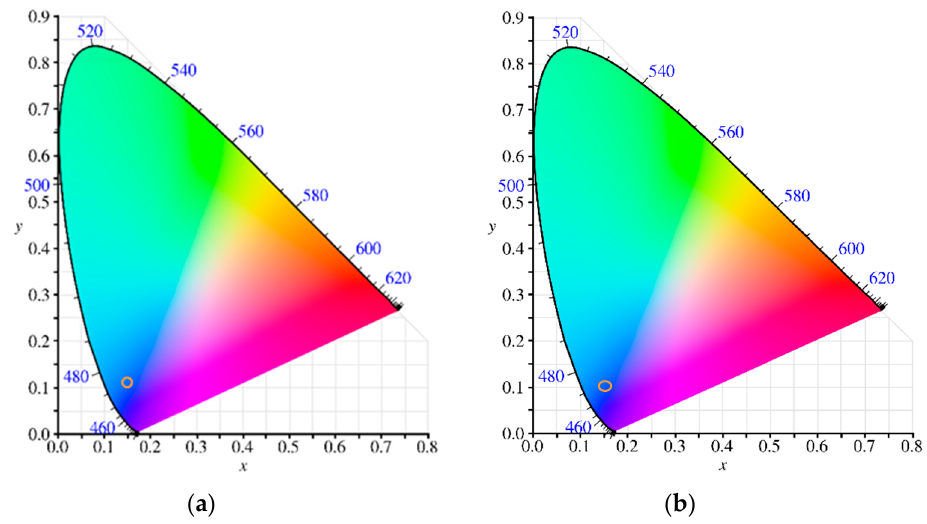
Figure 3. CIE chromaticity coordinates of a ) M1 (x = 0.15, y = 0.12) and b ) M2 (x = 0.15, y = 0.10). λ ex = 370